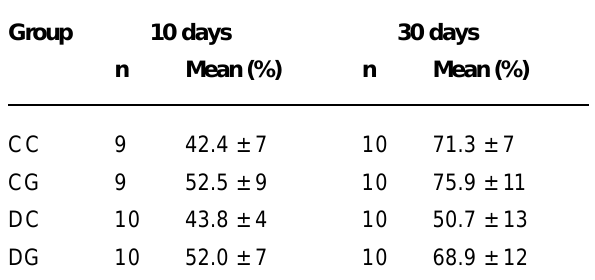
TABLE 1- Percentage of newly formed bone per